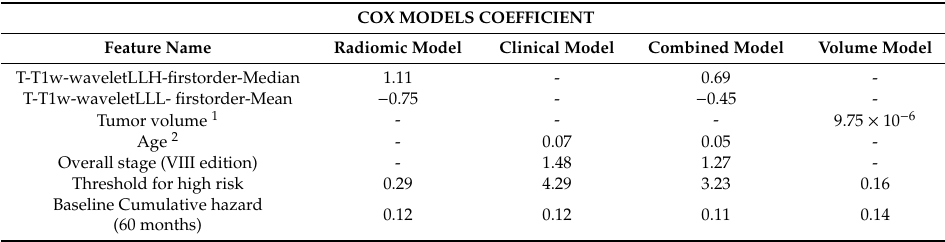
Table 4. Regression coe ffi cients for the four Cox proportional hazard regression models (radiomic, volume-based, clinical and combined clinical-radiomic). The coe ffi cients are displayed up to the second decimal digit. For radiomics features, the coe ffi cients are used to multiply the normalized features after Z-score. The threshold to discriminate high and low risk groups and the baseline hazard risk at 60 months are also